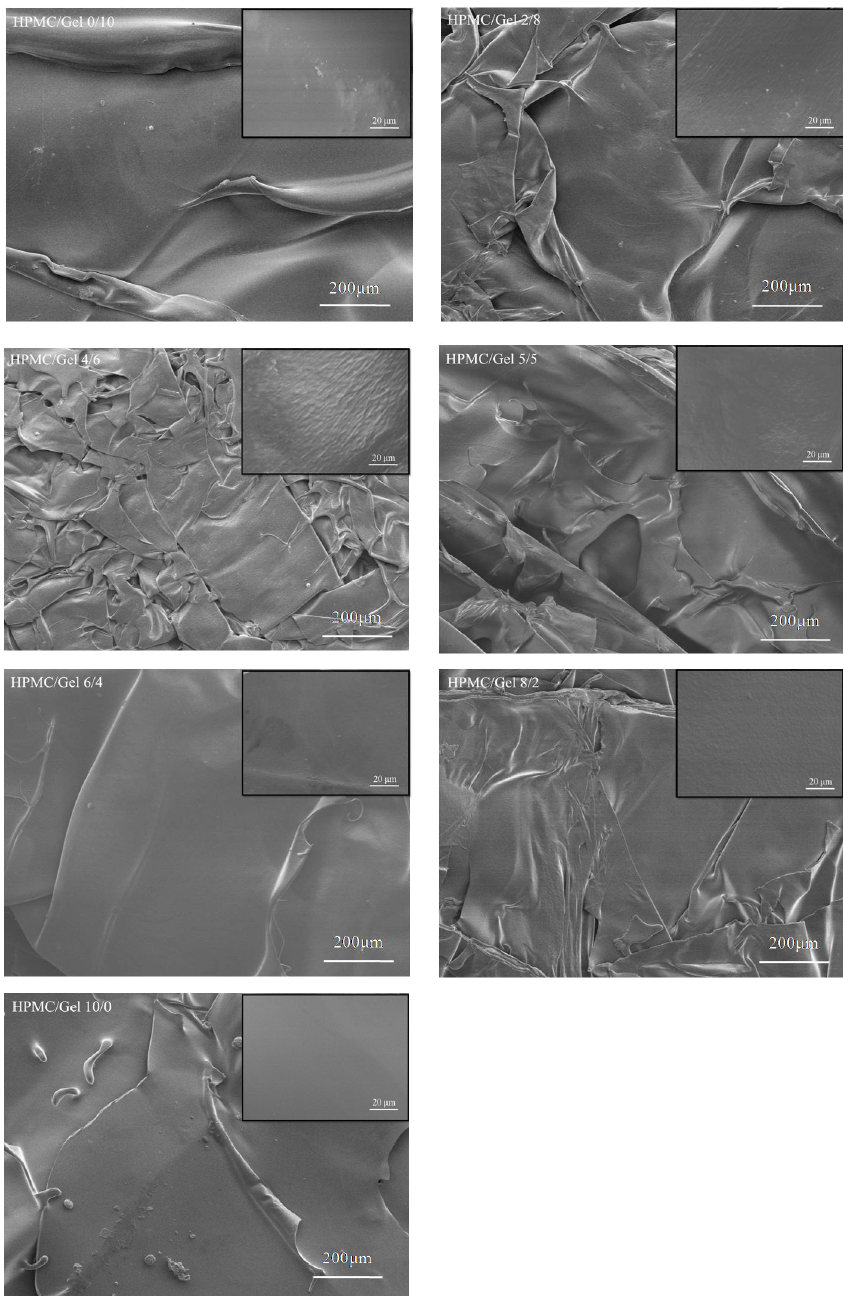
Figure 5. SEM images of freeze-dried blending